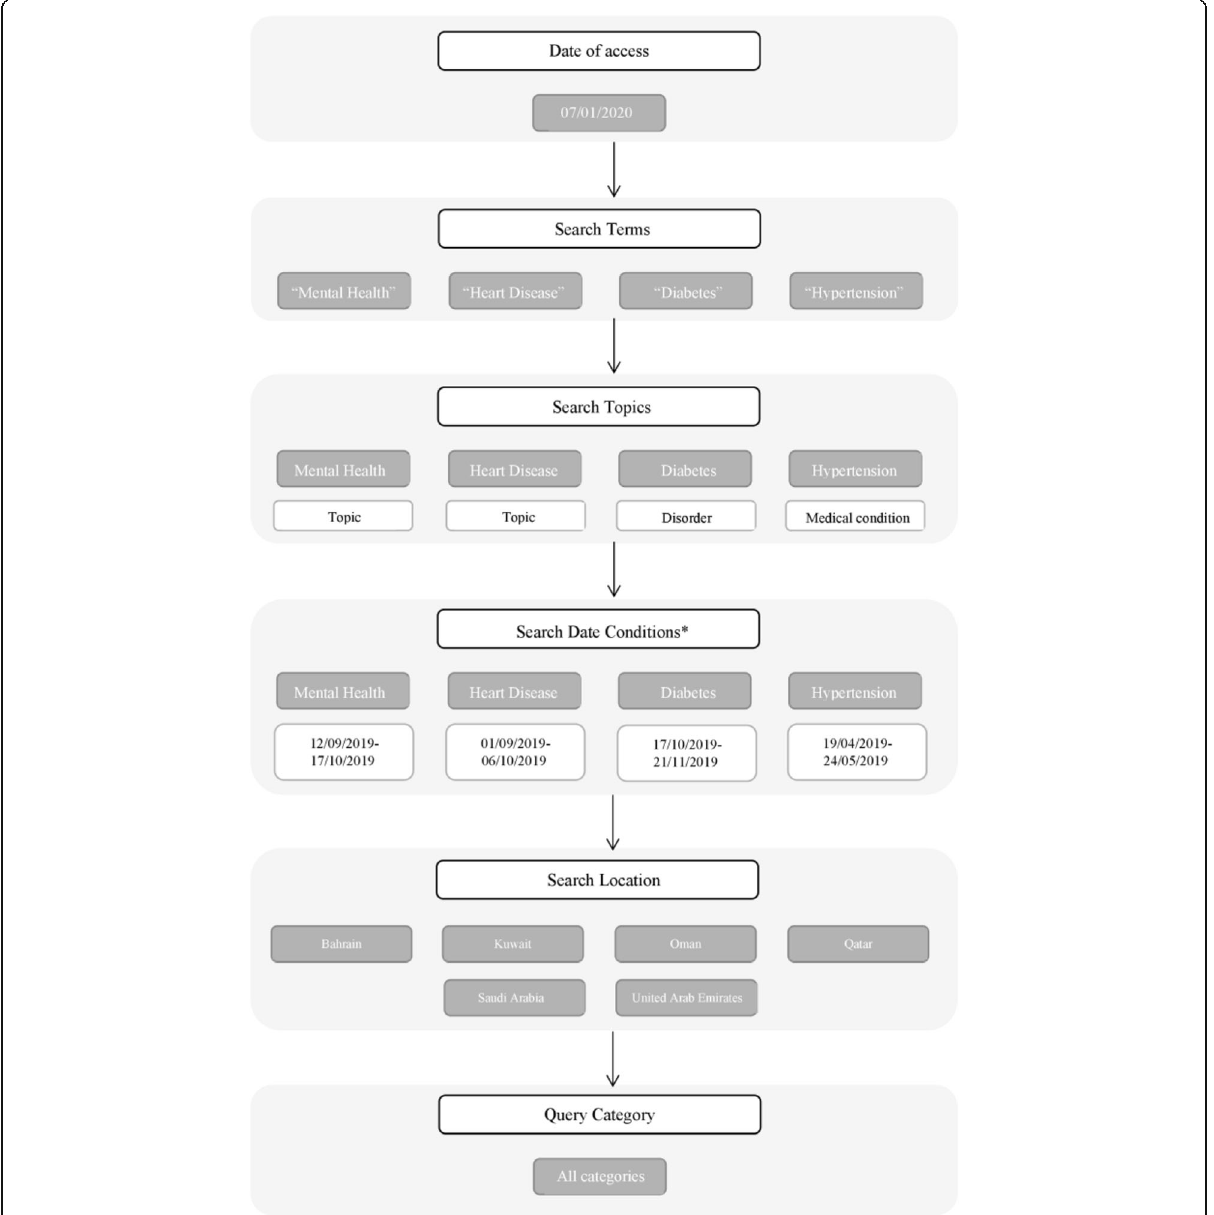
Fig. 1 Flowchart depicting the search methodology. *Search Dates include a total of 36 days, 28 days before global public health day and 7 days